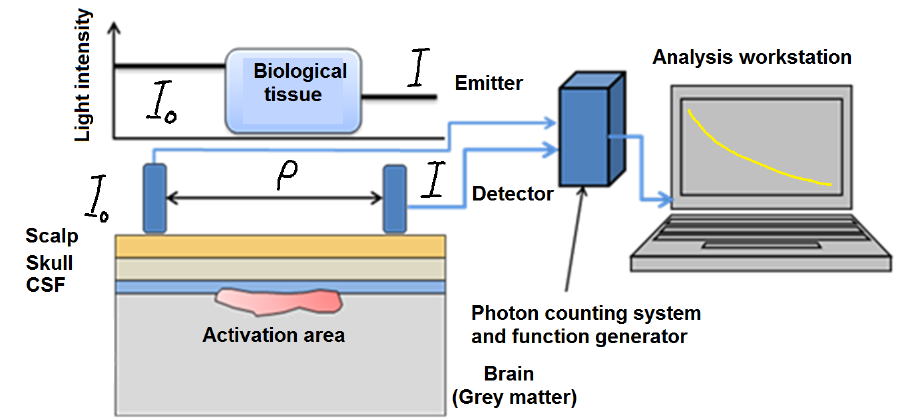
Figure 5. Basic mechanism illustration of the light absorption in NIR imaging of biological tissue. CSF: cerebrospinal